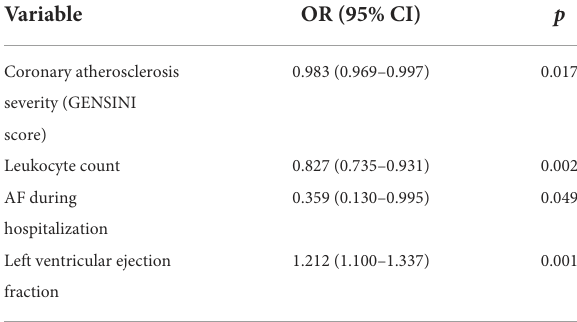
TABLE 4 Multivariate logistic regression of factors associated with systolic function improvement to EF to > 40% during